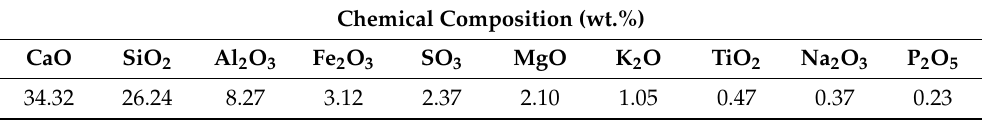
Table 3. Chemical composition of the concrete slurry waste (obtained by XRF spectroscopy). Chemical Composition (wt.%) Figure 3. Concrete slurry water collection process.